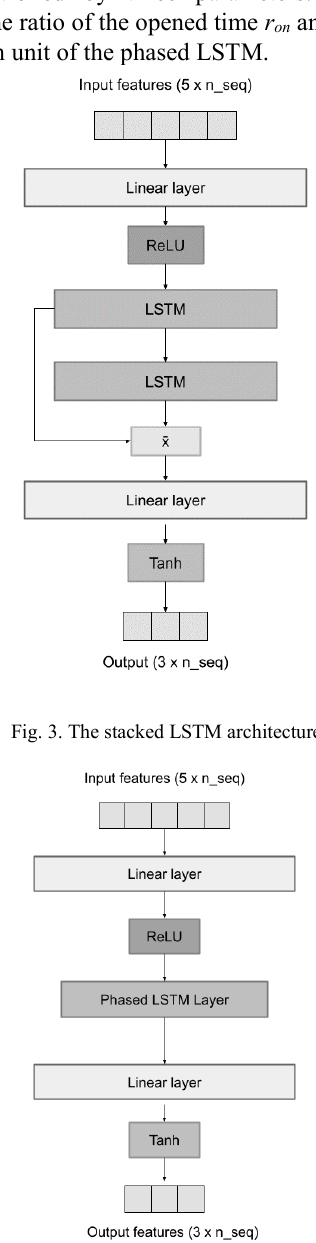
Fig. 4. The phased LSTM with peephole